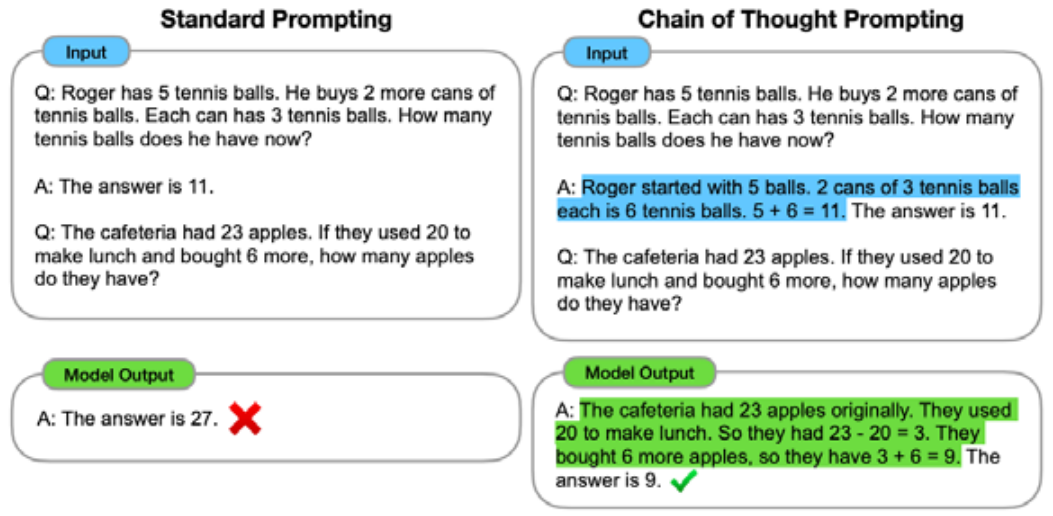
Figure 5 Using the method of chain-of-thought to guide the model to generate correct answers. Due to the use of few-shot learning method in this case, the model imitates the processing in the similar questioning and logical example given above and transforms the new and complex problems into each step of simple but basic according to the chain-of-thought. This method enables the model to learn how to logically decompose complex problems into simple steps and tackle them respectively. The advantage of doing so is to improve the generalization ability of the model in tasks that require strong logic, such as solving mathematical problems